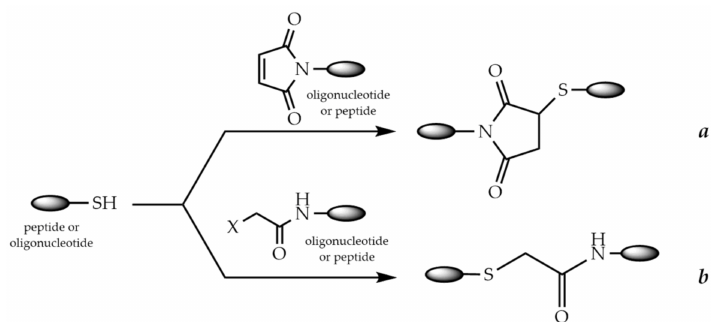
Figure 9. Conjugation through the thioether bond: ( a ) Michael addition of thiols to maleimides and ( b ) nucleophilic substitution of haloacetamides; X = I, Br, or Cl.